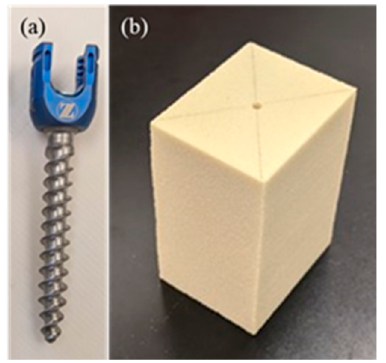
Figure 2. Experimental sample: ( a ) polyaxial pedicle screw, ( b ) artificial bone.